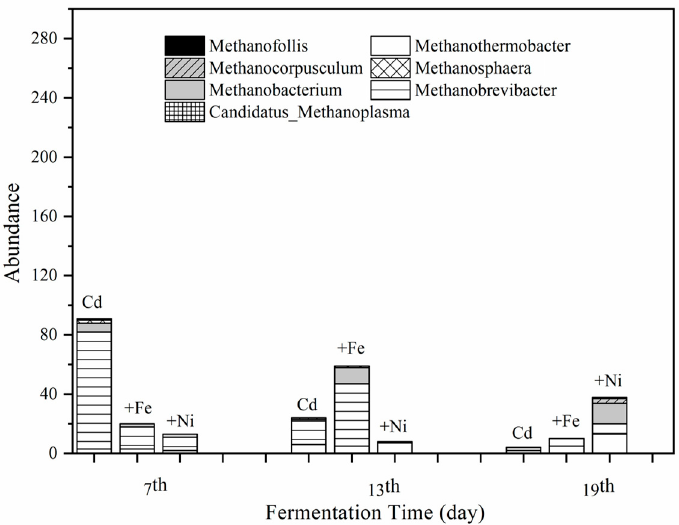
Figure 7. Impact of Cd, Cd + Fe, and Cd + Ni addition on the absolute abundance of methanogens during the fermentation.